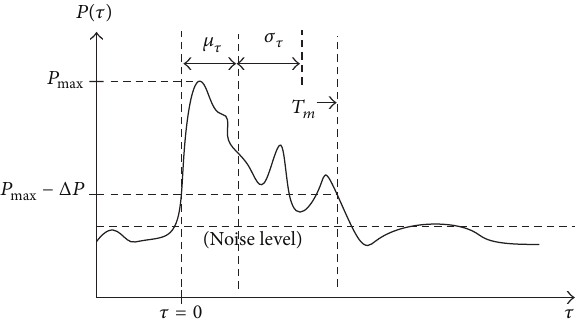
Figure 1: Power delay profile and its characteristic parameters in time